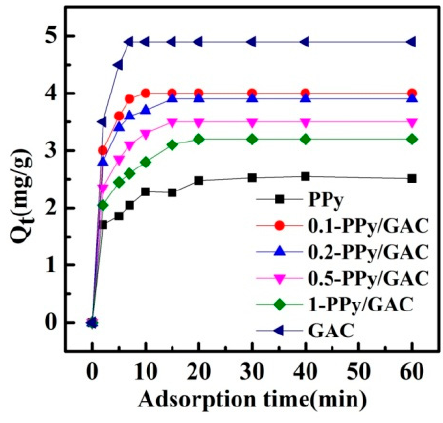
Figure 4. Adsorption equilibrium curves of MTBE on different adsorbents. Table 3. Parameters for the pseudo-first-order and pseudo-second-order models. Adsorbent